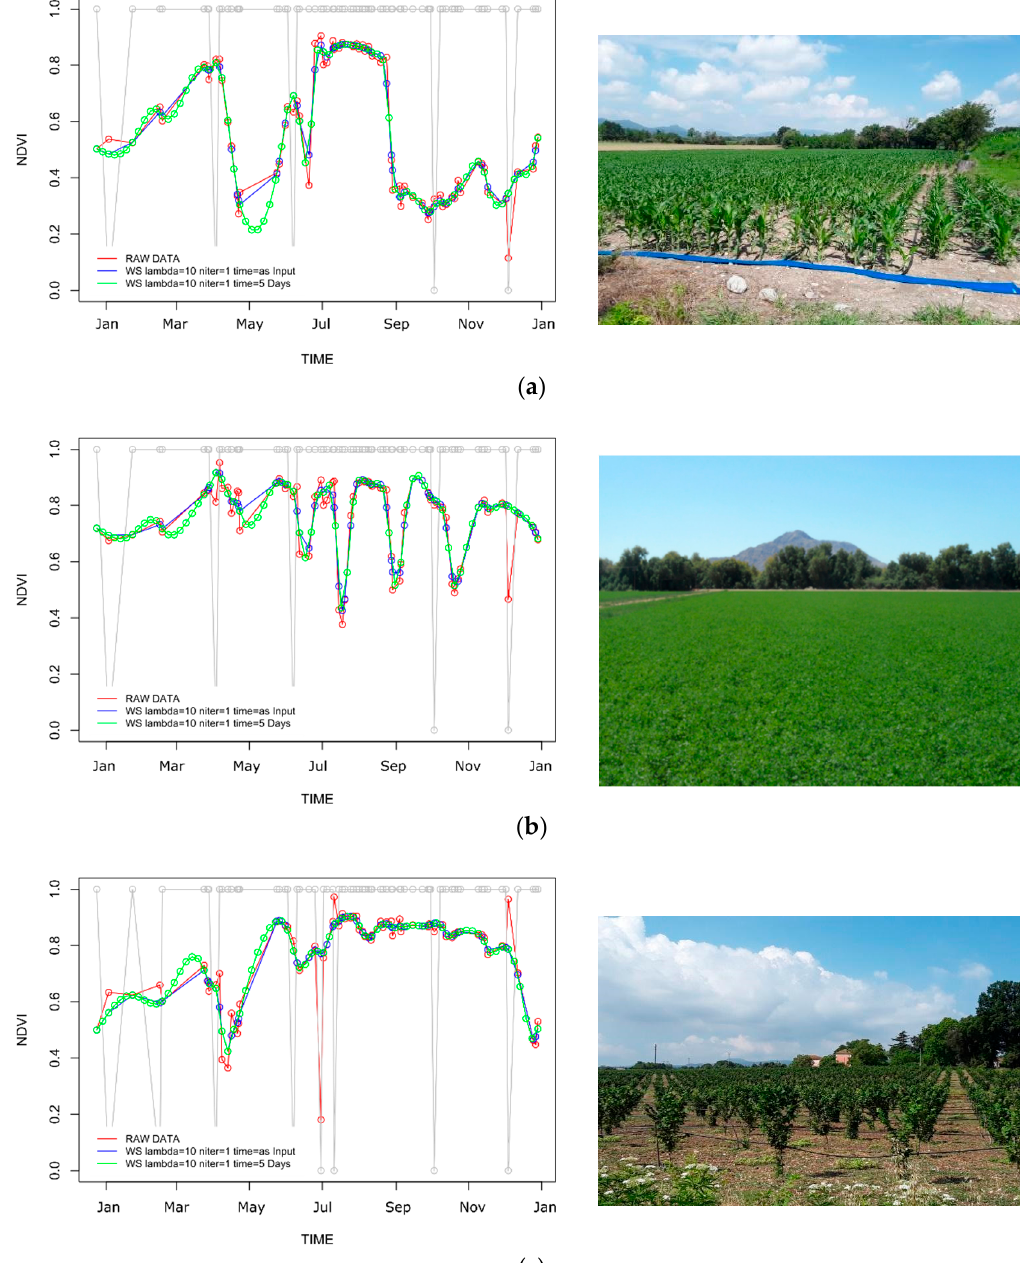
Figure 3. NDVI (left panel) and picture (right panel) for different crop types: (a) herbaceous (maize), (b) herbaceous (alfalfa), and (c) tree crop. In the NDVI panel, the red line represents the raw NDVI data, the blue line shows the NDVI after applying smoothing and gap-filling based on the by Whittaker smoother (WS) algorithm on the original dates (i.e., using the acquisition dates with variable time sampling), and the green line depicts the NDVI by running WS with a constant sampling of 5 days. The WS algorithm was run by applying two filtering iterations (niter = 1) in order to limit the effect of undetected clouds and poor atmospheric conditions. The smoothing parameter (lambda) was limited to 10 in order to preserve the fidelity of the input data in the final resulting curve, which was particularly relevant for the alfalfa herbaceous class as shown in panel b . The gray line indicates the presence (value = 0) or absence (value = 1) of clouds for a specific date.